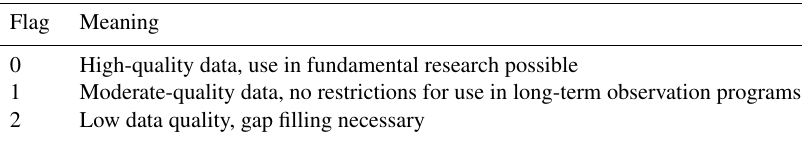
Table 6. Flag values set by the TK software and their meanings. Flag